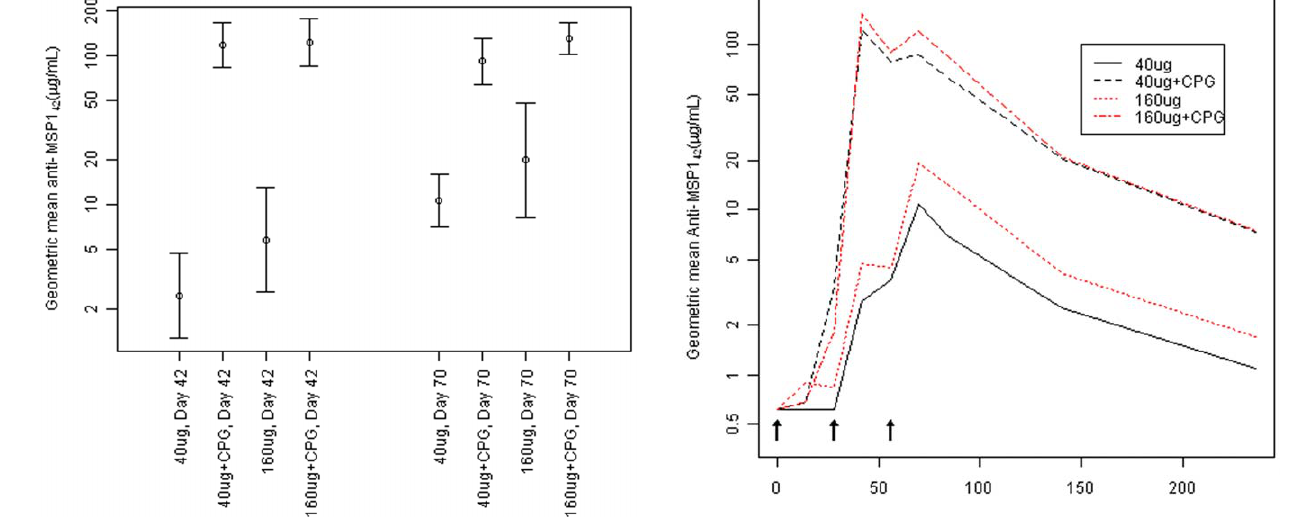
Table 3. Fold increase in antibody responses induced by vaccine with CPG 7909 compared to vaccine without CPG.